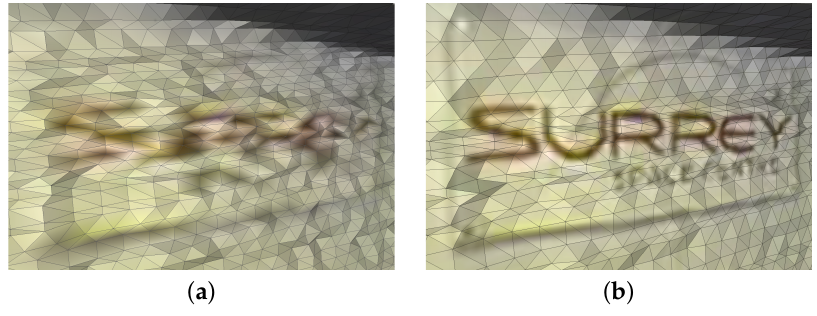
Figure 13. Surface mesh rendered with vertex colour ( a ); and texture mapped with full resolution RGB image ( b